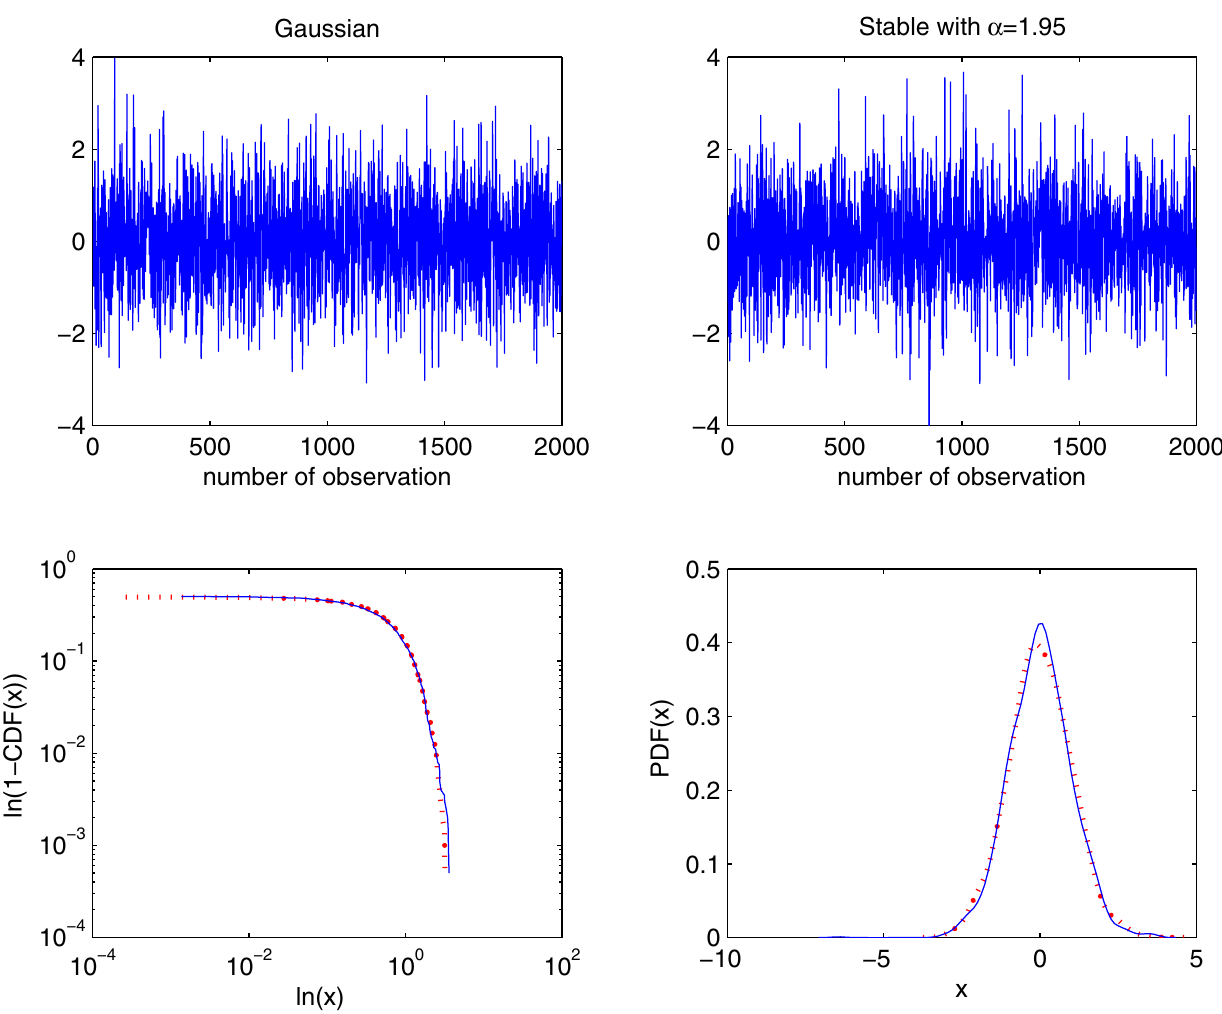
ffiffiffi p 2 (top left panel) and the symmetric stable distribution with α = 1.95